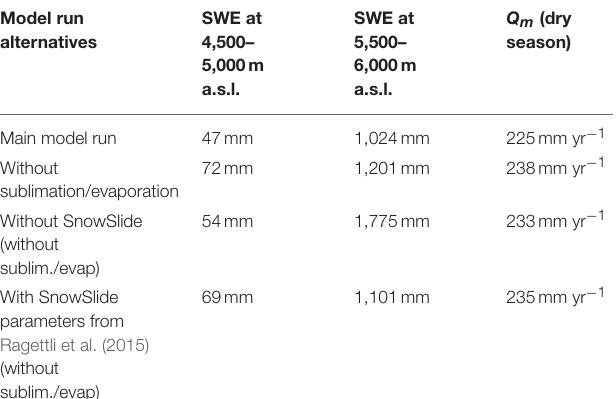
TABLE 2 | Summary results for the main model run as well as for three alternative model runs, where no sublimation/evaporation is taken into account, and where in addition the SnowSlide avalanching routine was switched off, or where alternative SnowSlide parameter values ( SS 1 , SS 2 ) from Ragettli et al. (2015) were used. Model run